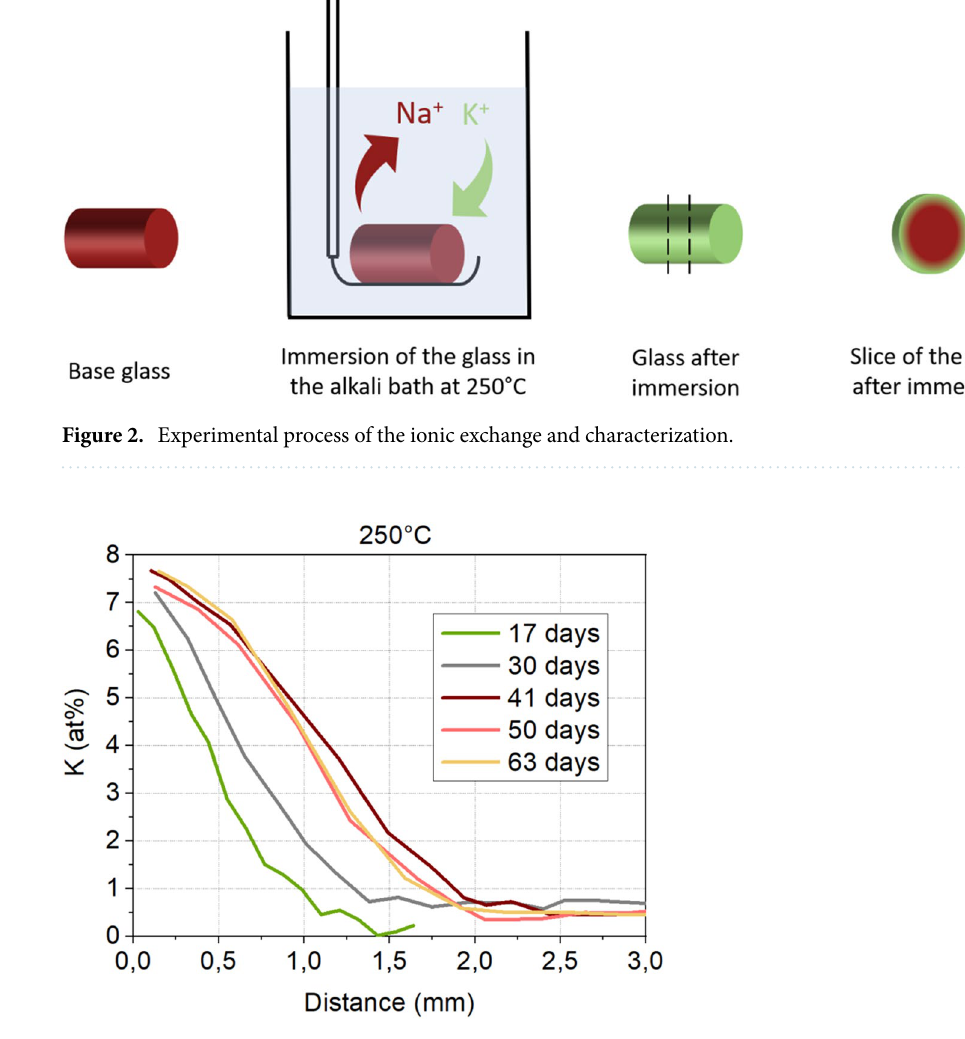
Figure 3. Potassium concentration profile in the (72 GeSe 2 –28 Ga 2 Se 3 ) 75 (NaI) 25 glass after immersion in the 60